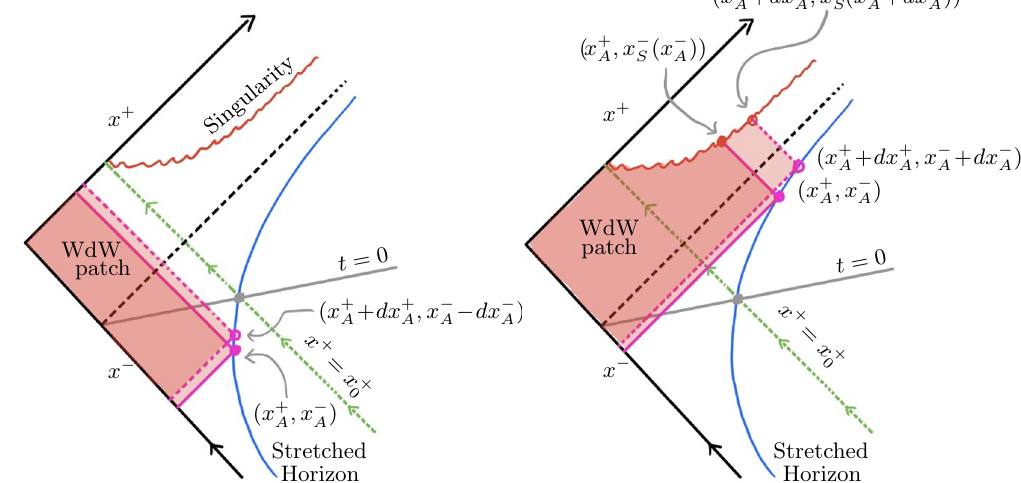
Figure 2 . Evolution of the WdW patch for classical gravitational collapse. Color coding coincides with (cid:12)gure